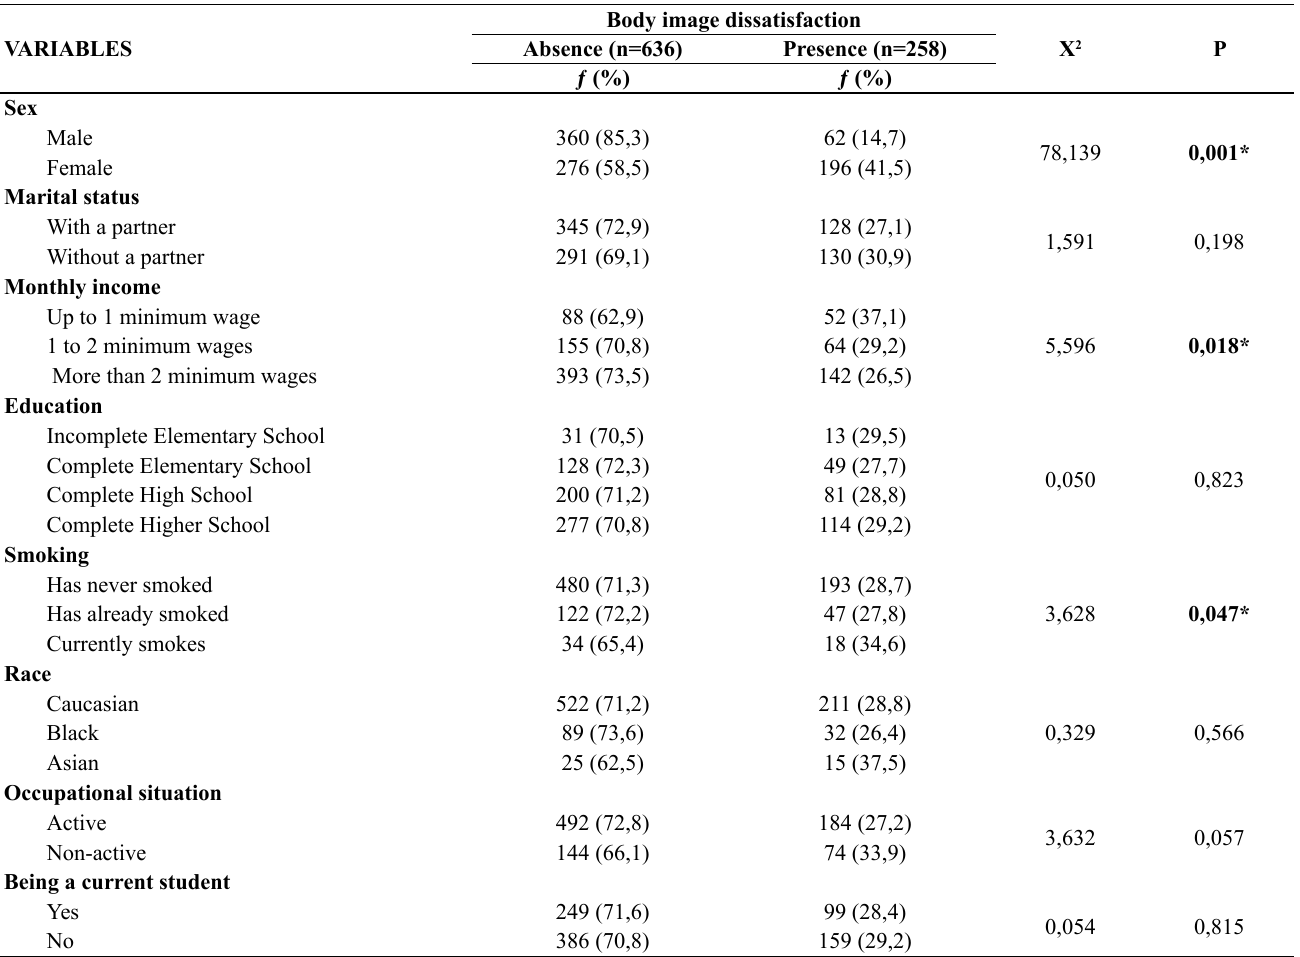
Table 3 . Association between body image dissatisfaction and the socio-demographic variables of weight training practitioners in Maringá, Paraná, Brasil.